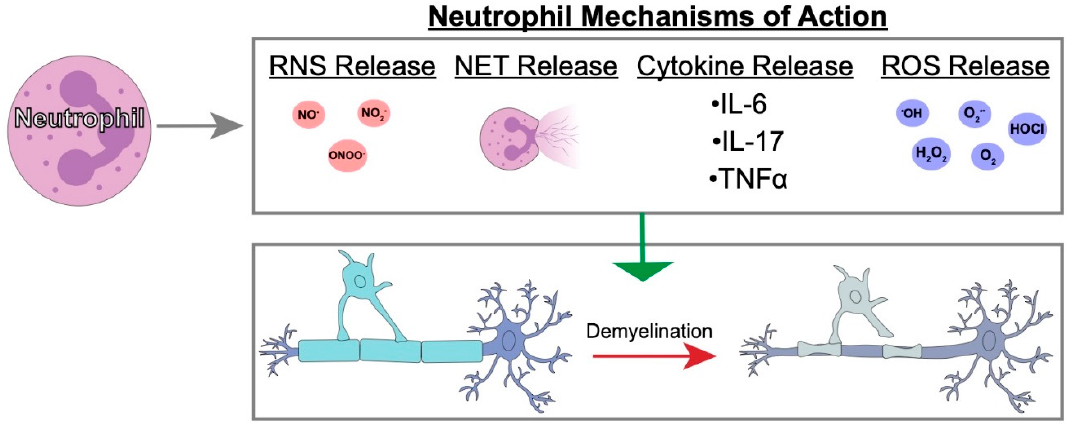
Figure 3. Characterization of possible neutrophil mechanisms of action that contribute to white matter damage. Cartoon depiction of neutrophil mechanisms of action including release of reactive nitrogen species (RNS) [105] and reactive oxygen species (ROS) [106] intermediates, neutrophil extracellular traps (NETs) [83], and select cytokines [107]. We hypothesize that these mechanisms may be responsible for the enhanced white matter damage observed following induced infiltration of neutrophils in preclinical mouse models of MS.